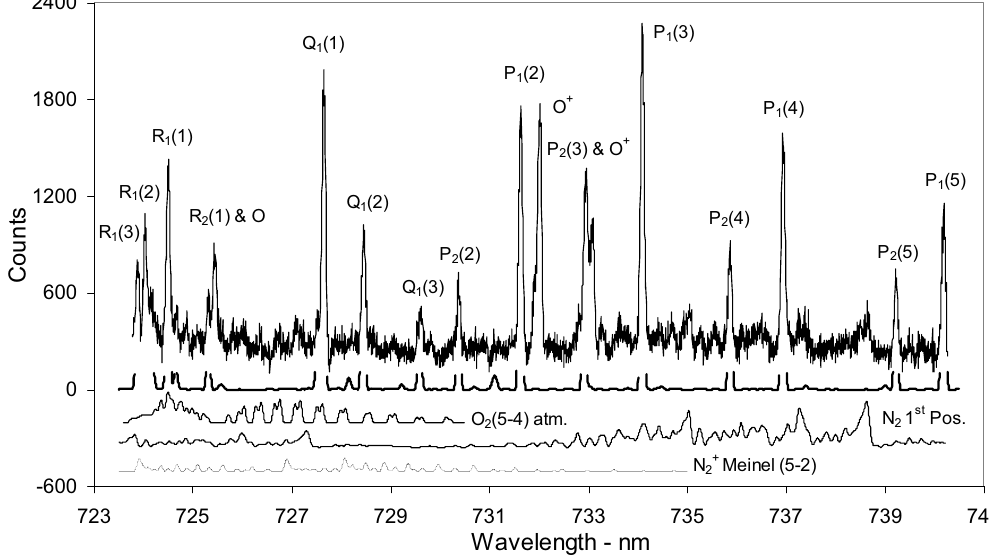
Fig. 2. Auroral contamination (116 summed spectra, Moon below horizon, aurora apparent). A theoretical hydroxyl and O 2 (5–4) Atmo- spheric, N 2 1 st Positive and N + Meinel (5–2) theoretical auroral spectra are shown below the summed 2